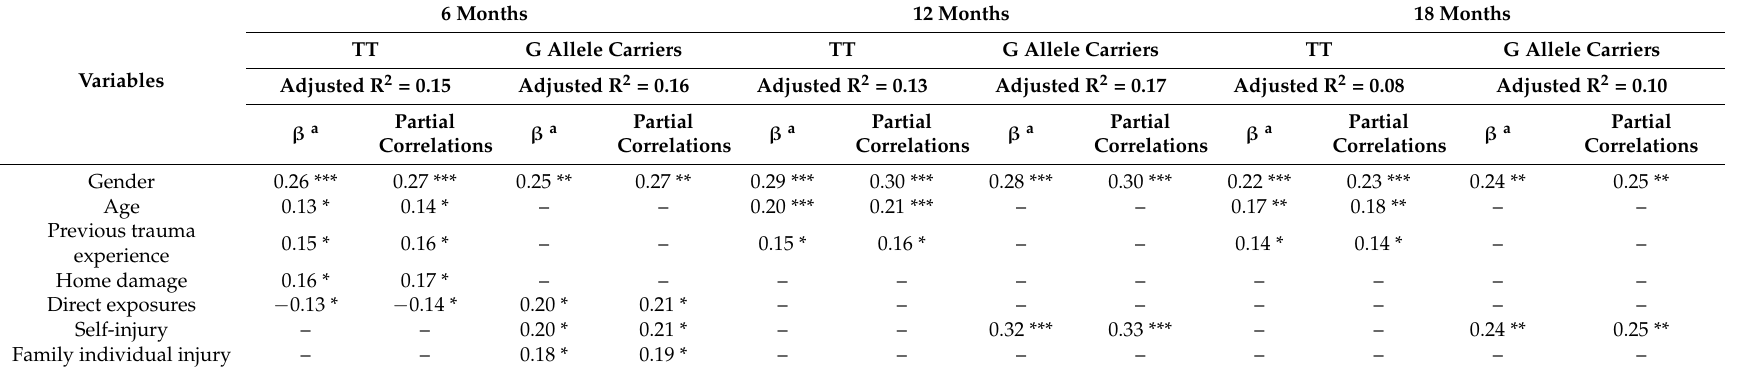
Table 5. Predictors of BDI scores in the subjects with different genotypes of TNFRII rs1061622 at 6, 12, and 18 months after the